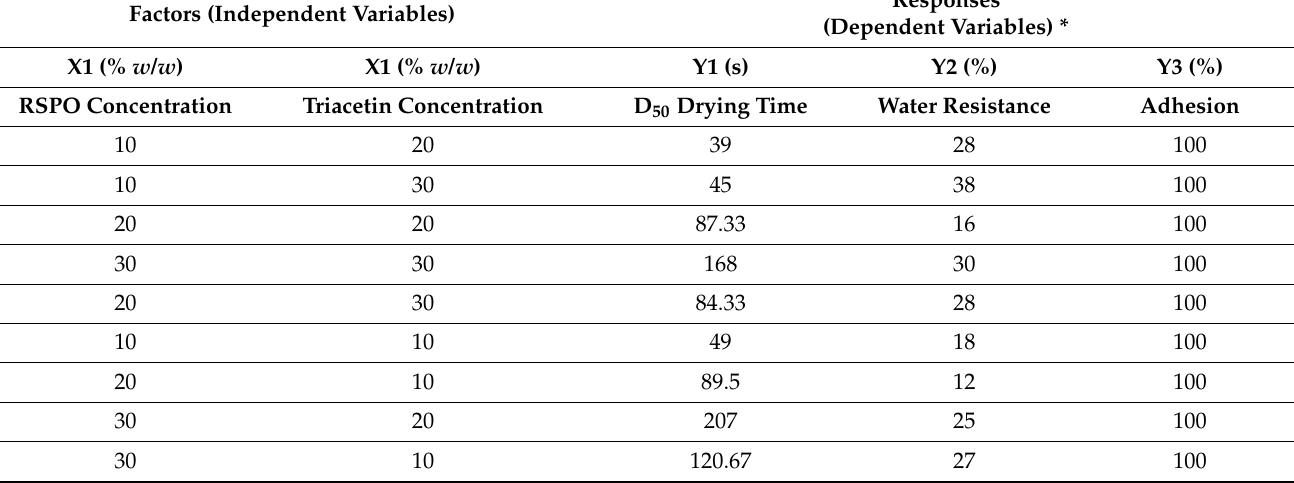
Table 6. Randomized experimental trials for the antifungal lacquer formulations containing one polymer and one plasticizer, at three levels each, and resulting responses.